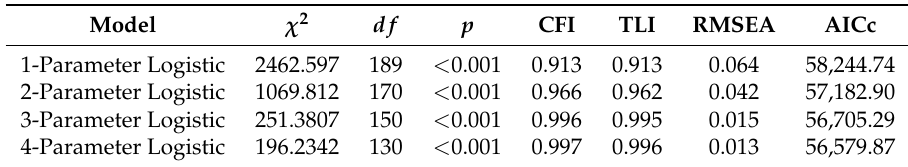
Table 1. Model fit of the binary